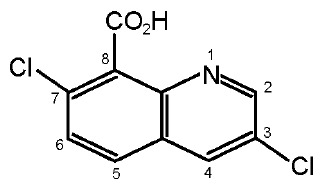
Figure 1: 3,7-Dichloro-8-quinolinecarboxylic acid. IUPAC name of